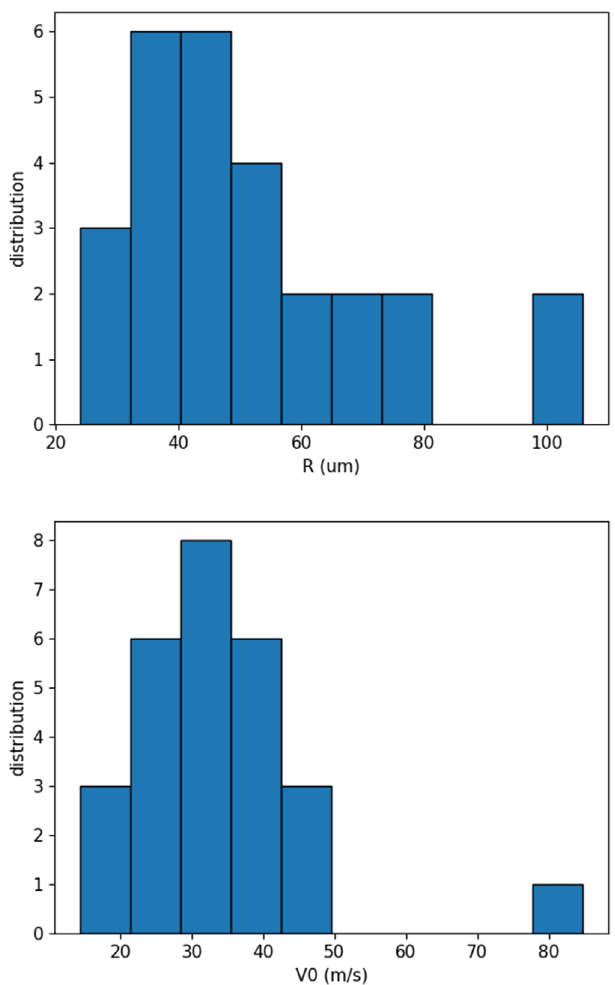
Fig. 6. Histogram of the radii (top) and initial speeds (bottom), for 30 sparks of the hypoeutectoid steel with 100 N applied. Table 1. Average values and standard deviation of sparks ’ radius and initial velocity (hypoeutectoid steel).